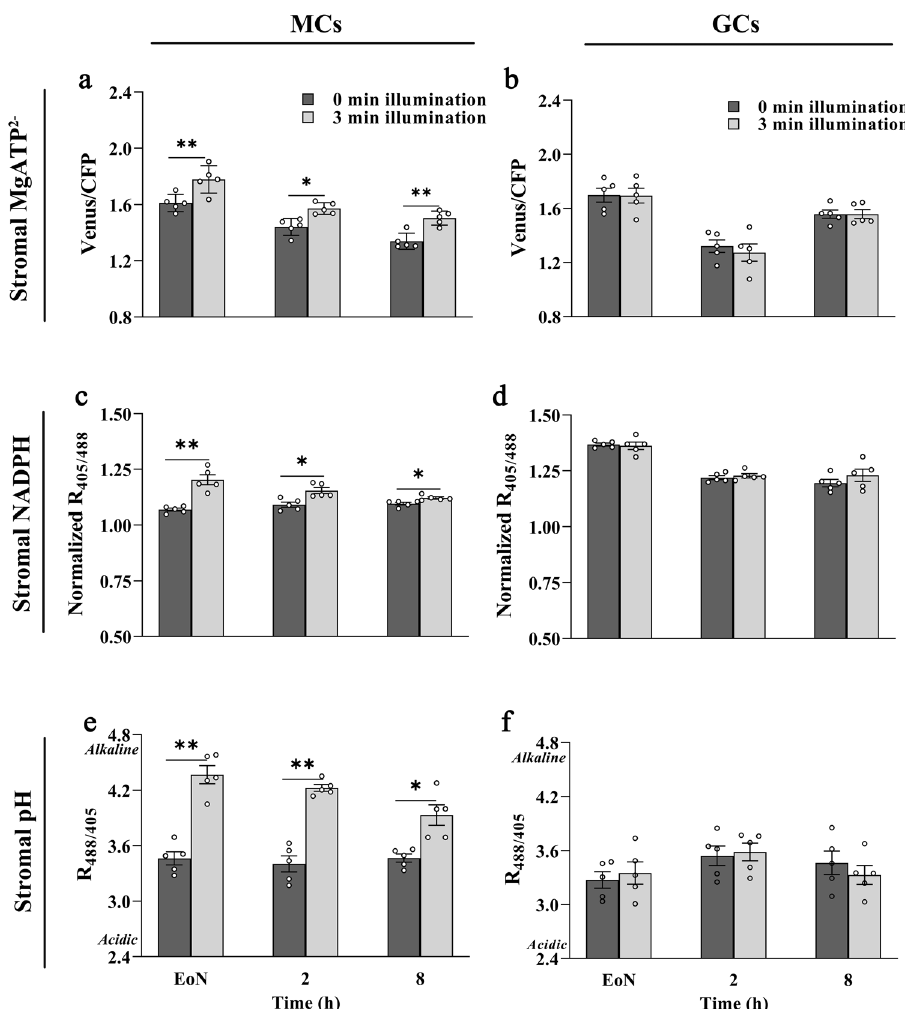
Fig. 1 Illumination induces detectable ATP and NADPH biosynthesis in mesophyll cell chloroplasts but not in guard cell chloroplasts. The 3 rd and 4 th leaves of 20- to 22-day-old wild-type Arabidopsis plants expressing TKTP-AT1.03 (ATP sensor), TKTP-iNAP4 (NADPH sensor) or TKTP-cpYFP (pH sensor) were collected at three different time points (EoN, 2 h and 8 h into the day). a, b Stromal AT1.03 signals ( p -values of panel a: EoN = 0.012, 2 h = 0.036, and 8 h = 0.010), c, d Stromal iNAP4 signals ( p -values of panel c: EoN = 0.004, 2 h = 0.032, and 8 h = 0.015), and e, f Stromal cpYFP signals ( p -values of panel e: EoN = 0.002, 2 h = 0.002, and 8 h = 0.017) from mesophyll cells (MCs, a , c , e ) and guard cells (GCs, b , d , f ) in response to white light illumination at 216 μ mol m − 2 s − 1 for 180 s. The iNAP results presented here were normalized to TKTP-iNAPc. EoN, End of night. Asterisks indicate signi fi cant statistical differences (* P < 0.05, ** P < 0.01) before and after 180 s of illumination, as determined by a paired t -test, two-tailed ( n = 5; mean ± SEM). Source data are provided as a source data fi